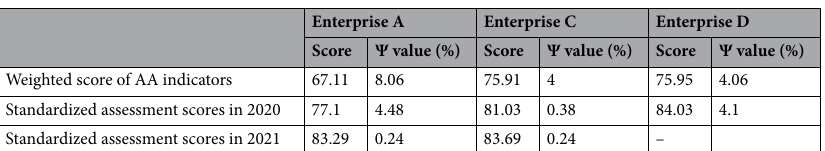
Table 10. Results of the total standardized management system score compared to the weighted score of AA indicators.